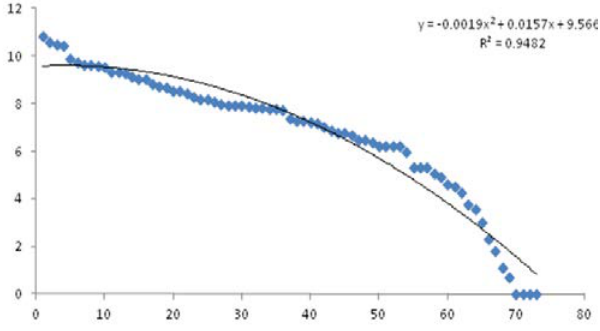
Fig. 5. Relative abundance of aquatic birds in wetlands of UP. Data on X axis is number of species encountered and Y axis number of individuals of corresponding species observed, converted to natural log